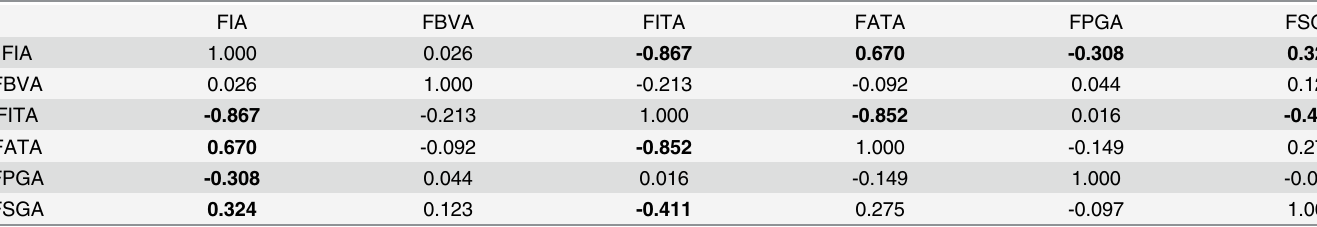
Table 2. Correlations between morphometric variables (FIA, FATA) and corresponding pathology descriptors (IF, TA). Pearson correlation (r) FIA vs . IF FATA vs . TA Trichrome